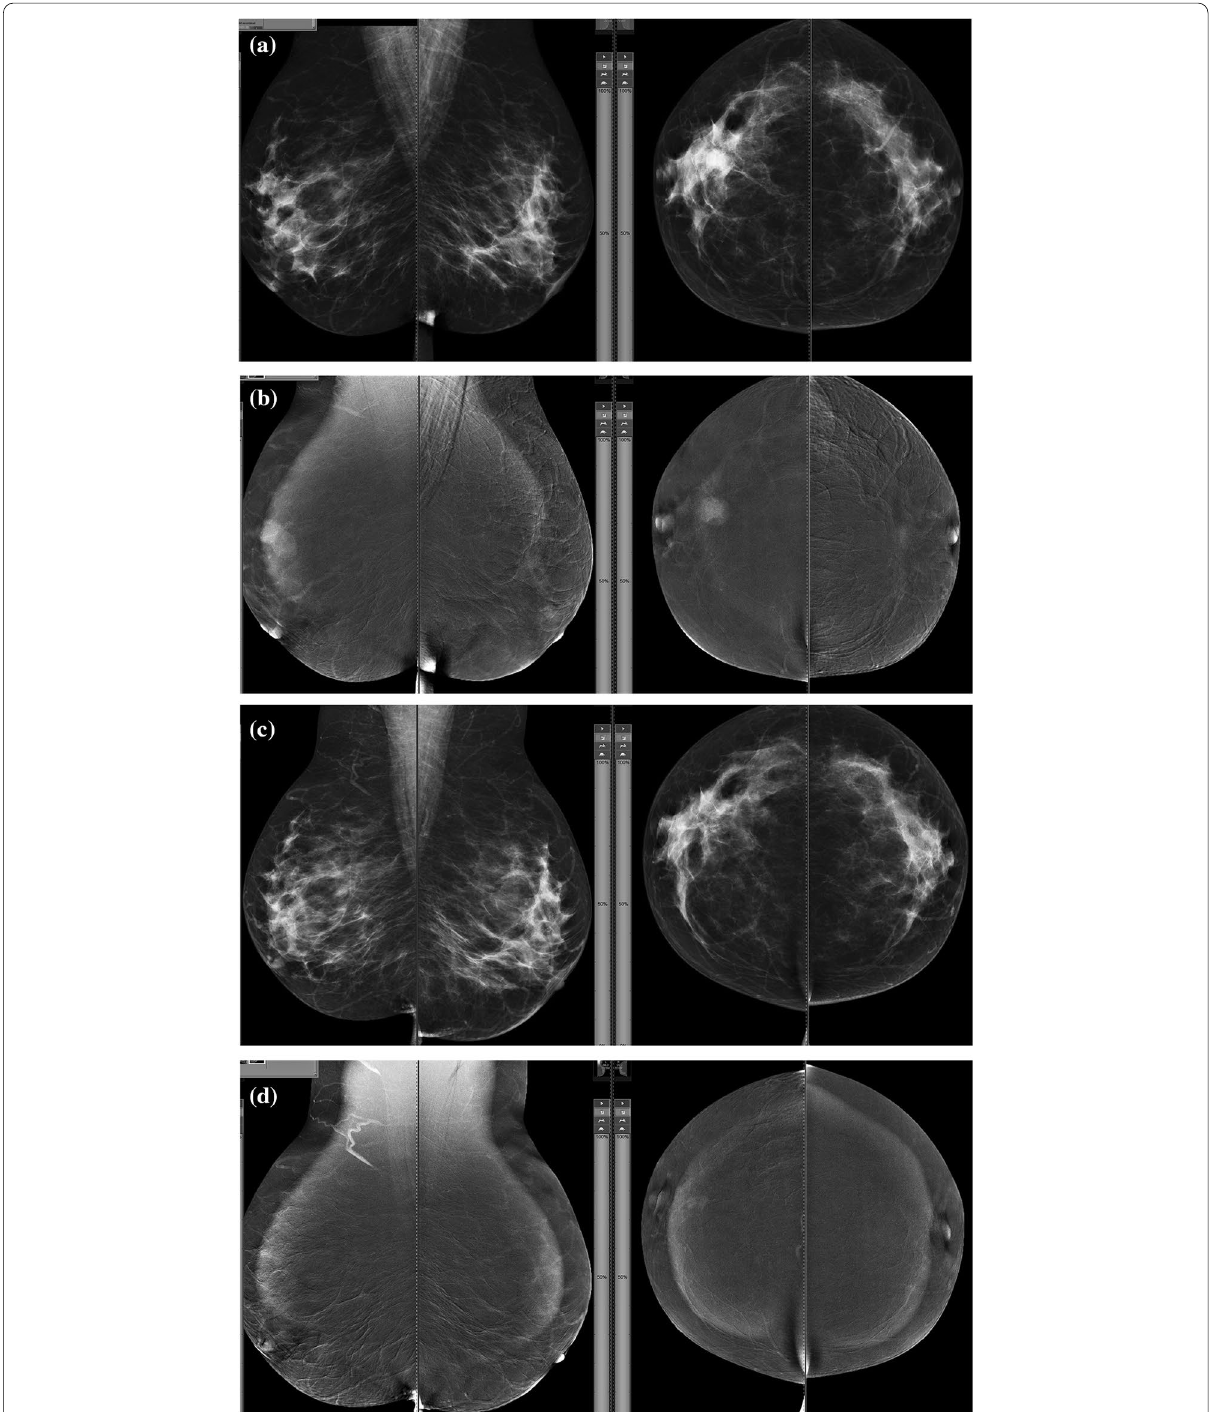
Fig. 3 a Full‑field digital mammography in MLO and CC views and b CESM in MLO and CC views in a 42‑year‑old woman with pathologically proven invasive duct carcinoma showing a right breast UOQ dense mass lesion with obscured outlines showing intense enhancement at the post‑contrast study measuring 2.5 cm in longest diameter. c Follow‑up full‑field digital mammography in MLO and CC views and CESM in MLO and CC after neoadjuvant chemotherapy showing almost total resolution of the previously seen mass lesion with faint residual enhancing nodule measuring 1.5 cm indicating PR. The patient underwent wide local excision of the right breast lesion. Histopathology assessment revealed CR with no viable tumor cells, free resection margin, and free axillary lymph nodes